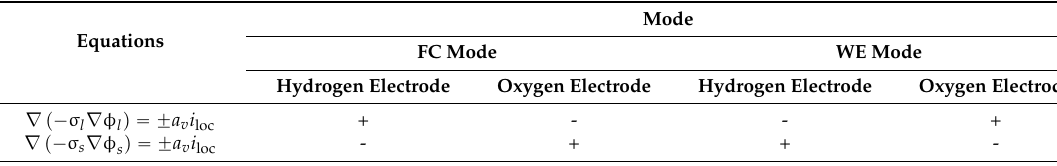
Table 1. Selection of signs for equations in FC and WE